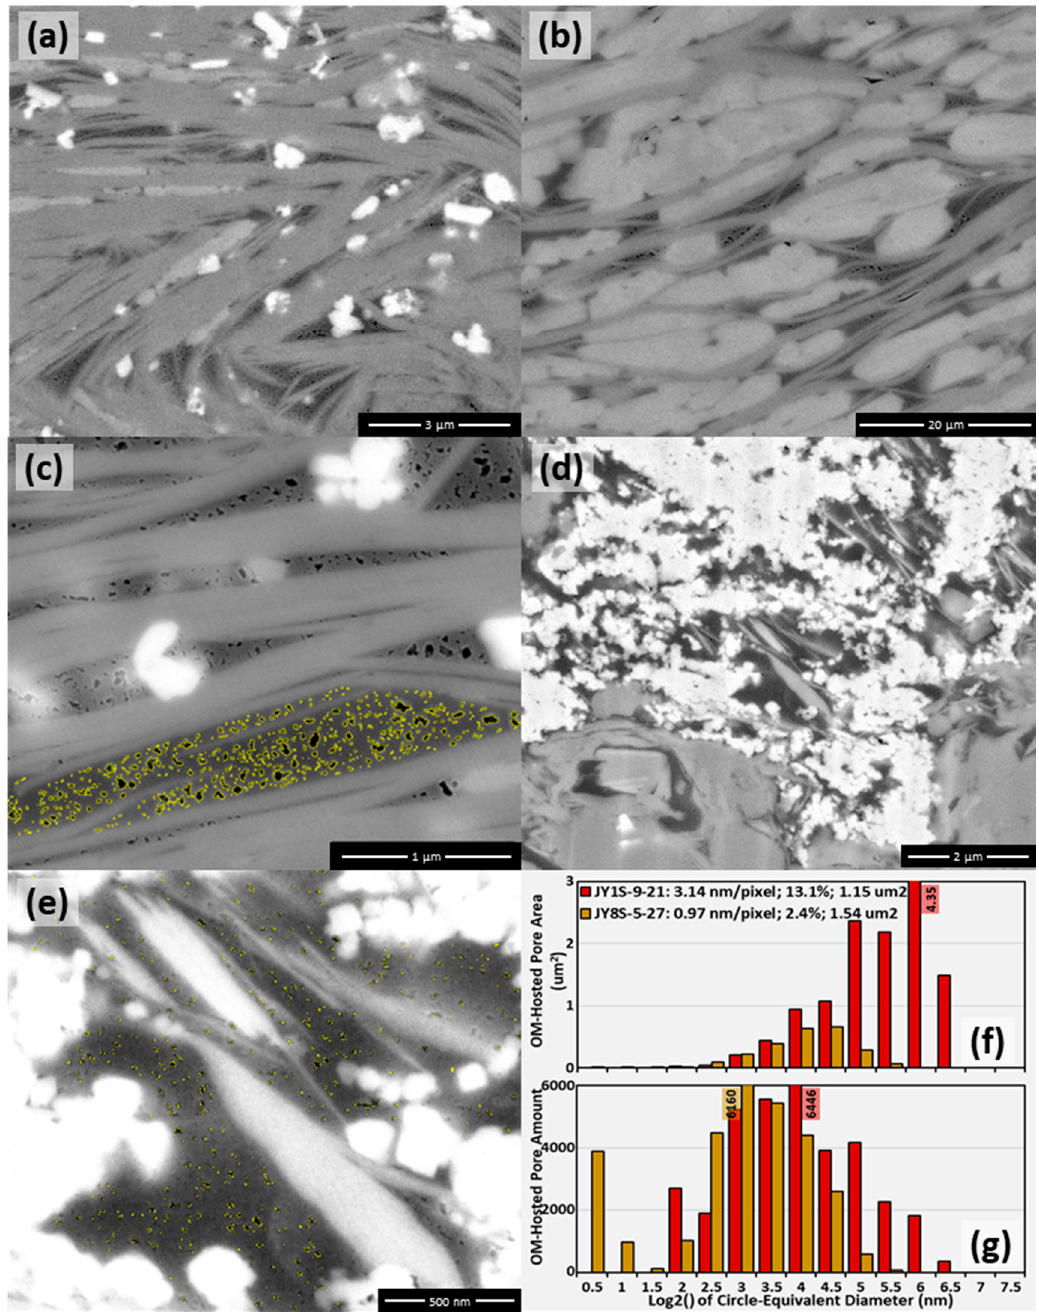
Figure 20. Examples of the amorphous kerogen enriched with mica and / or monocyrstal clay mineral as well as bio-quartz and bright minerals (OM X) from Longmaxi-Wufeng Shale, Sichuan Basin. ( a ) SEM image JY1S-9-20 (well ID-sample no.-image no.); ( b ) SEM image JY1S-9-23; ( c ) SEM image JY1S-9-21 with pores highlighted by yellow; ( d ) SEM image JY8S-5-26; ( e ) SEM image JY8S-5-27 with pores highlighted by yellow; ( f ) pore size distribution of OM-hosted pores determined by pore area; and ( g ) pore size distribution of OM-hosted pores determined by pore amount.